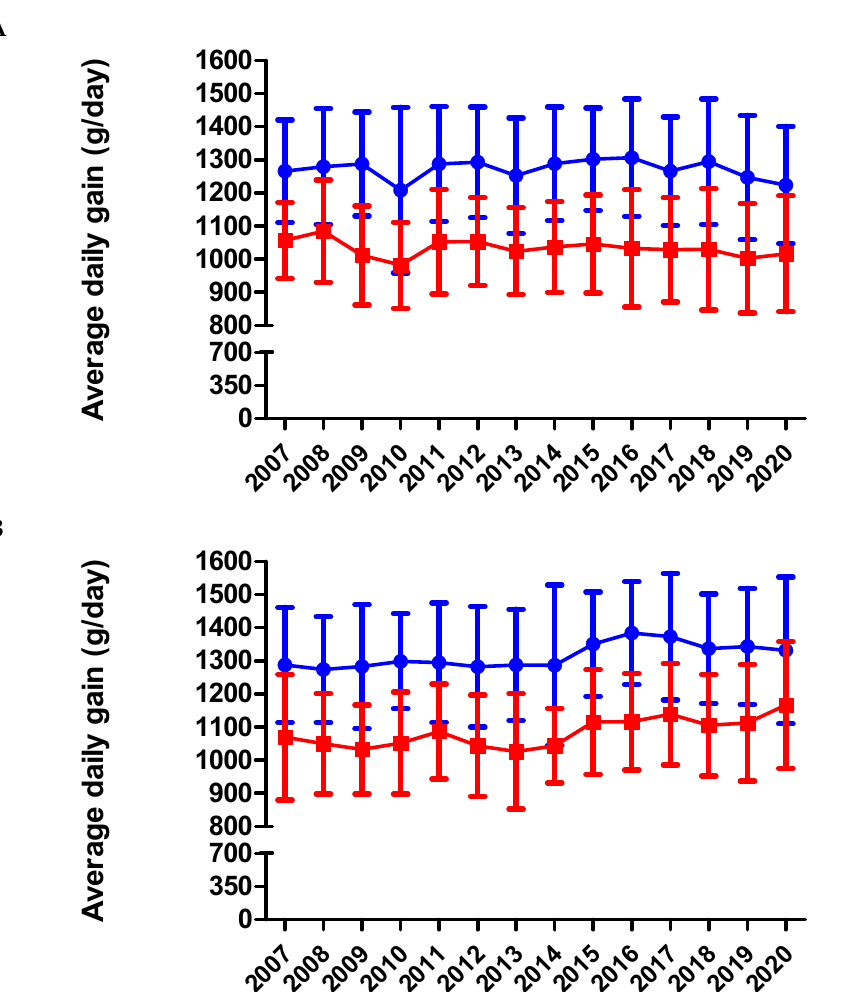
Figure 10. Average daily gain (g/day) from BA ( A ) and BAxL ( B ) split by males (blue filled circles) and females (red filled squares) from 2007 to 2020 in Andorra. Both genders of the BAxL crossbreed improved regarding ADG across the years ( p < 0.001) and had a better performance during the fattening process than BA animals ( p < 0.001). However, both genders of the BA pure breed showed a slight but significant decrease in ADG across the years ( p < 0.05).